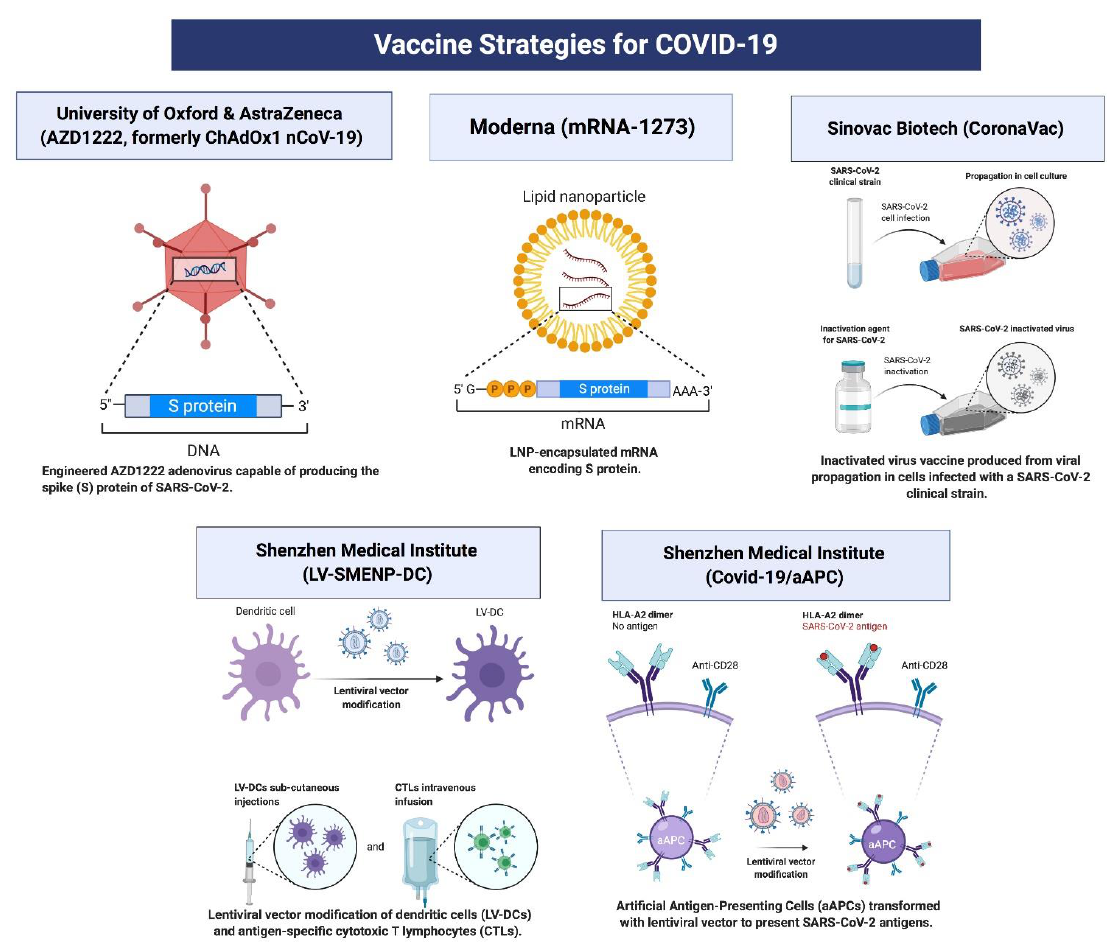
Figure 3. Schematic representation of some ongoing strategies for SARS-CoV-2 vaccine and their respective mechanism of action.